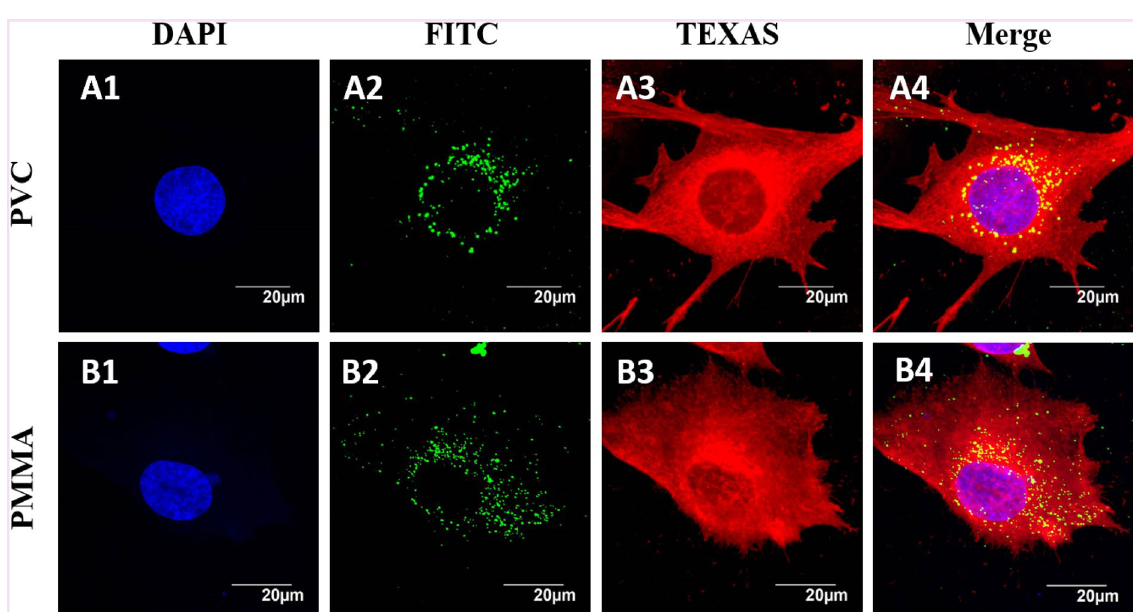
Figure 5. Confocal images of BHK-21 cells exposed to PVC ( A1 to A4 ) and PMMA ( B1 to B4 ) NPs at 200 µg/ mL in RPMI media. Cell membrane was stained with cell mask deep red (invitrogen) and nucleus stained blue with Hoechst